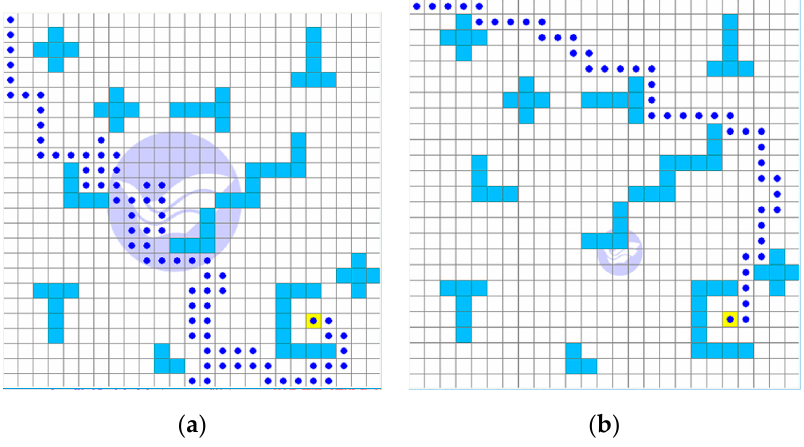
Figure 28. The experiment in Environment 2: ( a ) SARSA algorithm, ( b ) Q-learning algorithm.